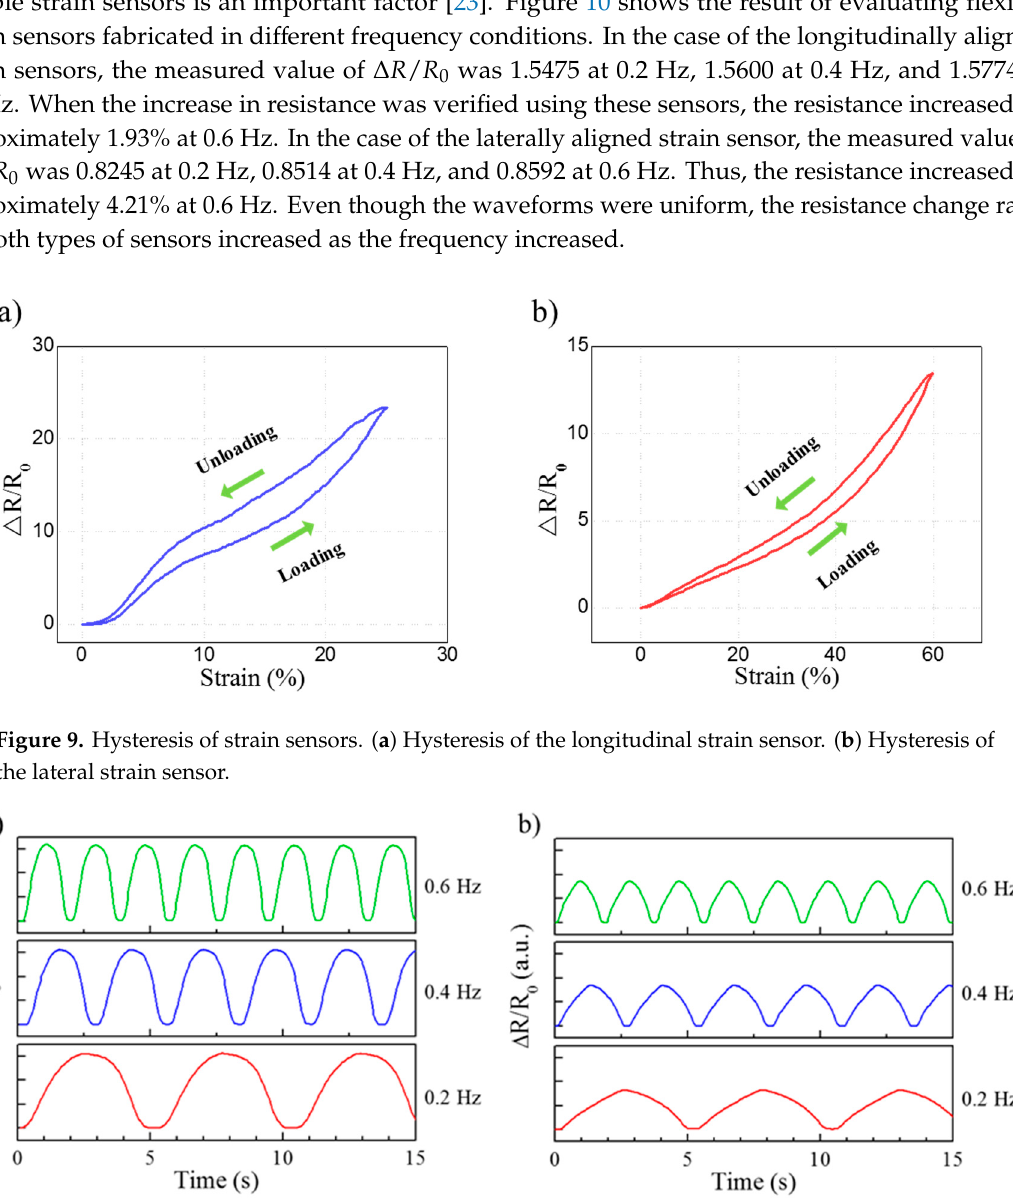
Figure 10. Frequency experiment. ( a ) Measurement of the resistance change rate according to the frequency of the longitudinally aligned flexible strain sensor at 5% elongation. ( b ) Measurement of the resistance change rate according to the frequency of the laterally aligned flexible strain sensor at 10% elongation.